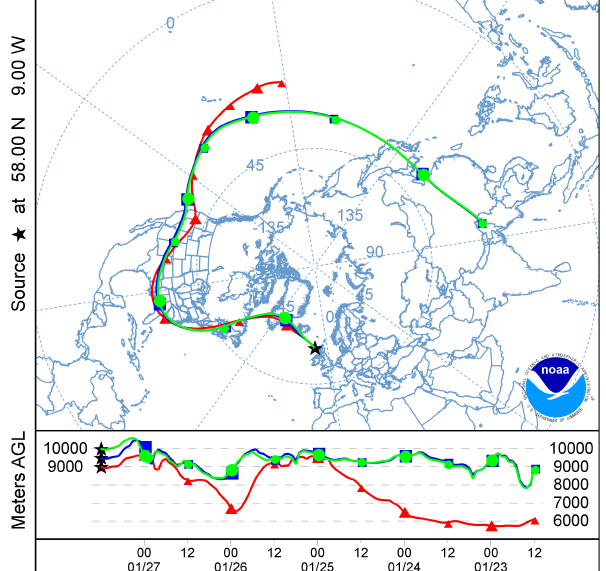
Fig. 1. 5-day backward air mass trajectories for cirrus flight B504 ending at 12:00UTC on 27 January 2010, computed for final alti- tudes of 9000, 9500 and 10000m. The lower panel shows the alti- tude above ground level in metres.